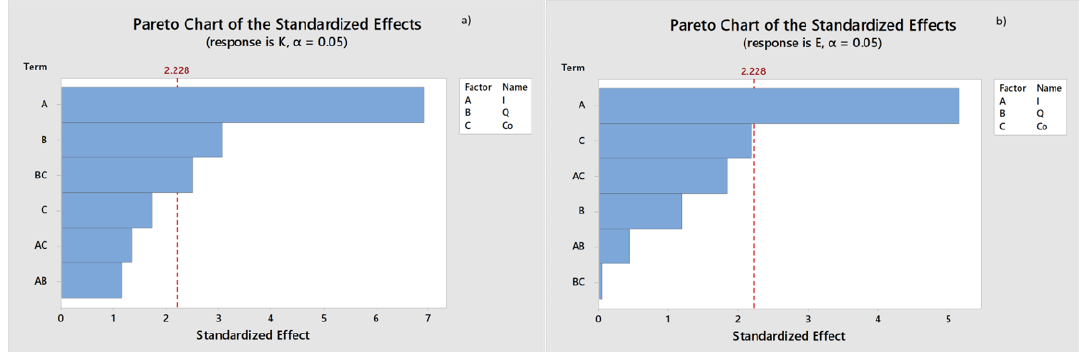
Figure 5. Pareto charts of standardized effects on K (panel a ) and E (panel b ) related to a significance level of 95%. (I, Q, C 0 stand for applied current, electrolyte flow rate and initial concentration, respectively).